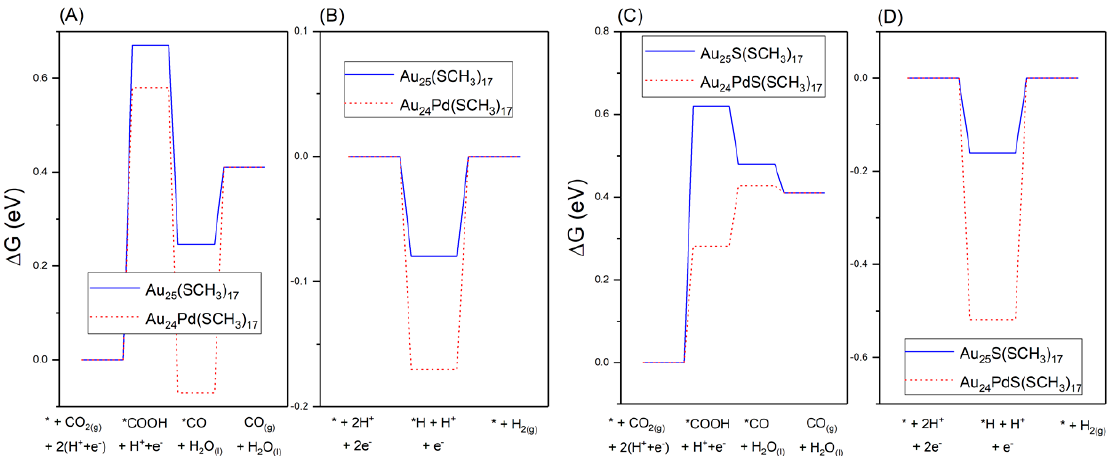
Figure 7. Free energy diagram of for electrochemical reduction of ( A ) CO 2 RR and ( B ) HER on the bare metal site of the dethiolated Au 25 (SCH 3 ) 18 and Au 24 Pd(SCH 3 ) 18 nanoclusters. The free energies of ( C ) CO 2 RR and ( D ) HER on the sulfur site of the demethylated nanoclusters are included for comparison.